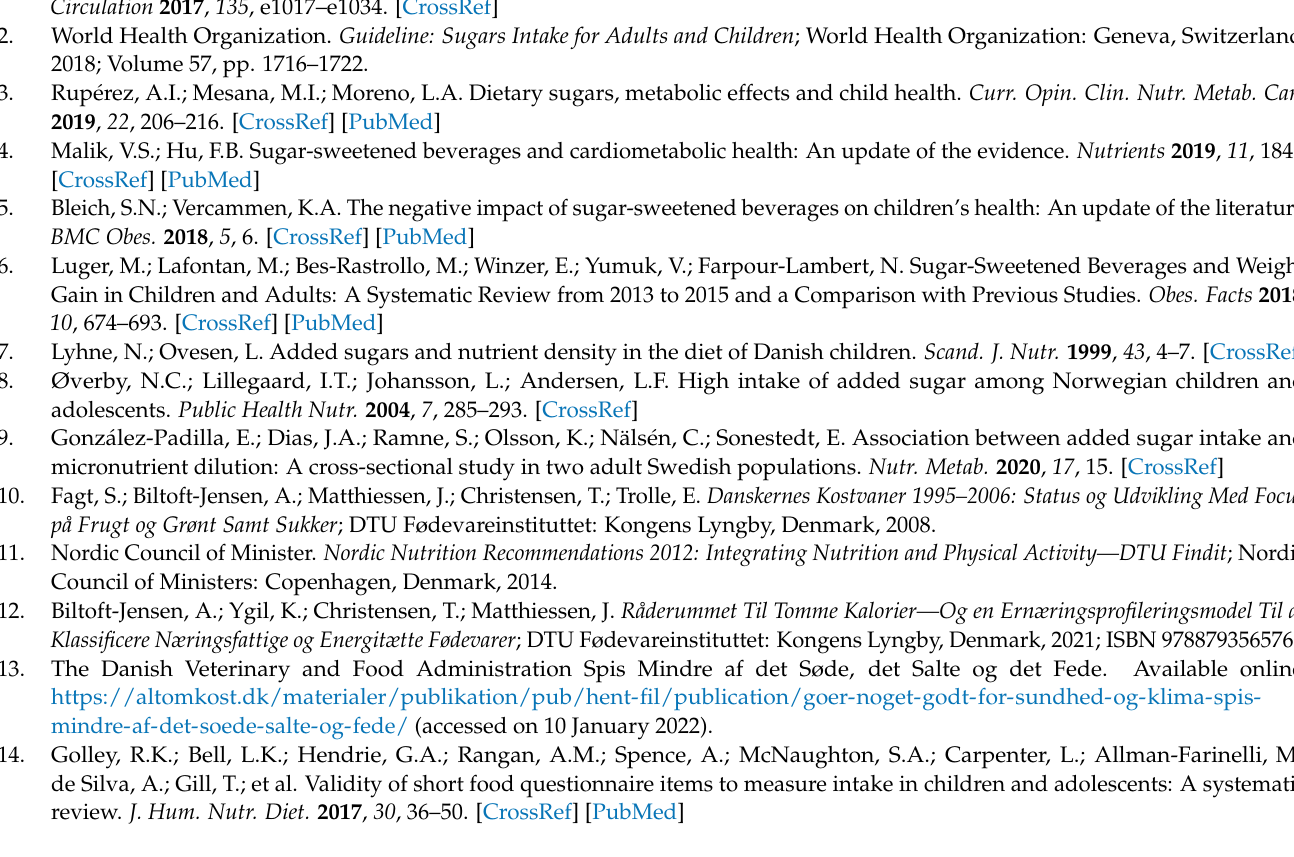
Figure A2. Screen shot from the SRFS. Website where parents chose the portion size of each discretionary food or drink their child had consumed and at which days this specific food was consumed. The pictures to the left and right are referring to portions of the same size.